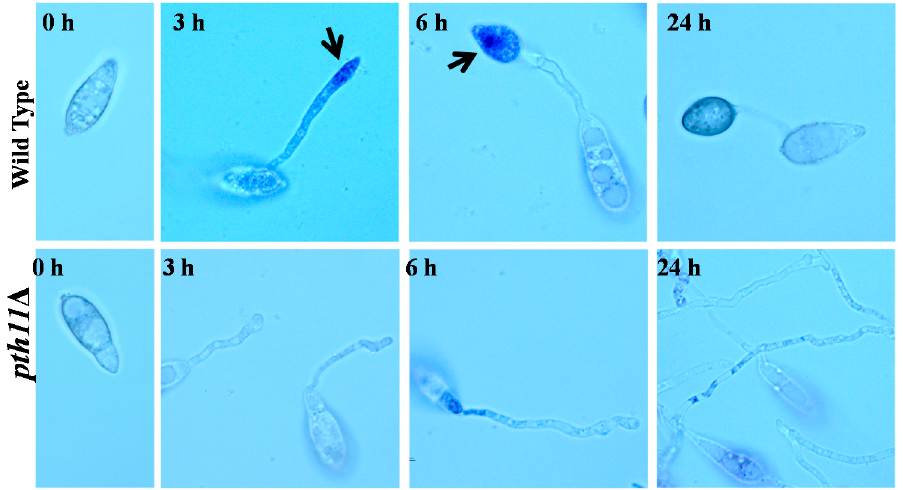
Figure 1. ROS accumulate in the tip of the germ tube and immature appressorium. Nitroblue tetrazolium (NBT) staining was performed in wild type or pth11 Δ strains during the appressorium formation [20]. Arrows highlight the ROS in the tips of its germ tubes and immature appressoria. Bar = 5 μ m.